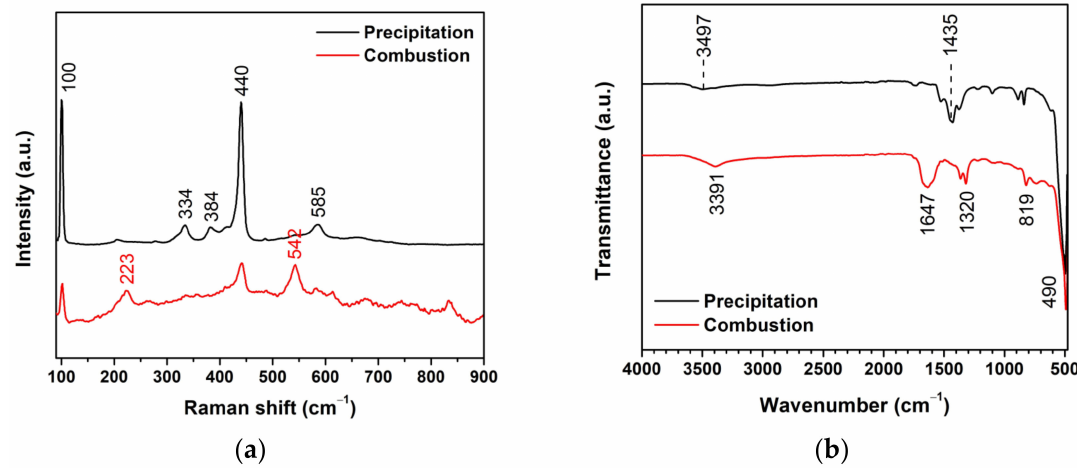
Figure 7. Vibrational analysis of ZnO NPs prepared by precipitation and combustion: ( a ) Raman shift and ( b ) FTIR